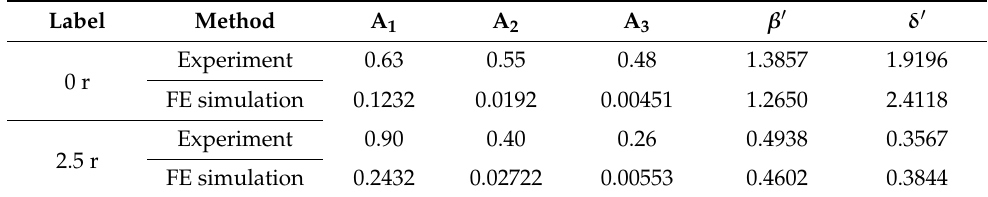
Table 3. Experimental and simulation results of the relative acoustic nonlinearity parameters (RANPs).